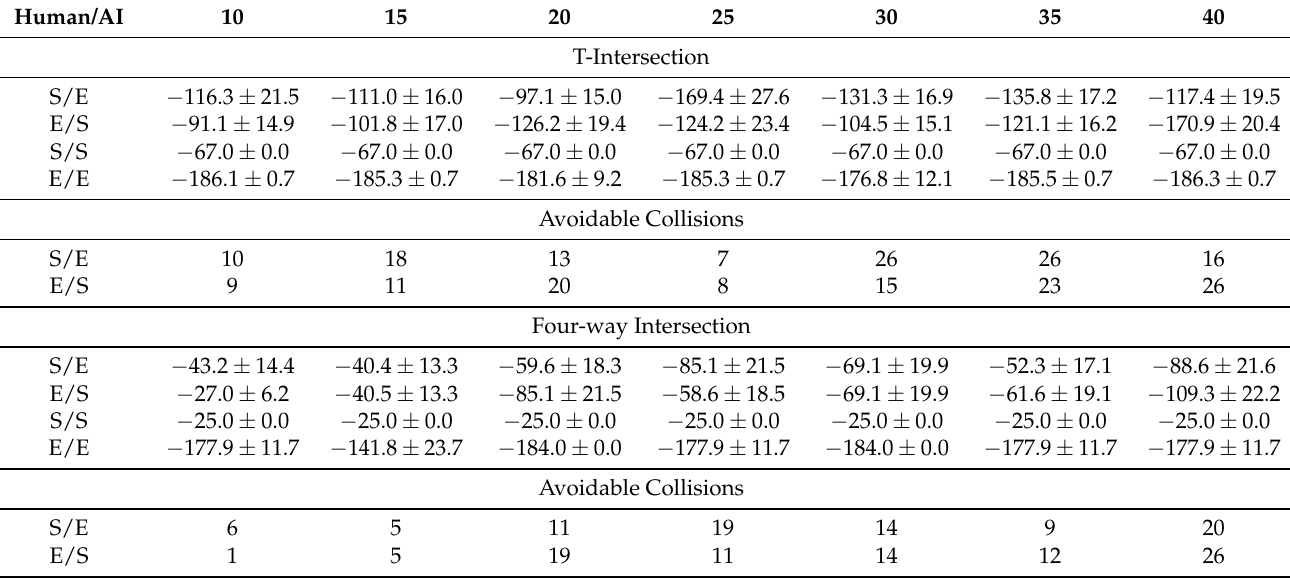
Table 18. Mean rewards and avoidable collision counts (by human–AI configuration) for a random manager with given delegation interval lengths in the human: light, AI: sensor and mask